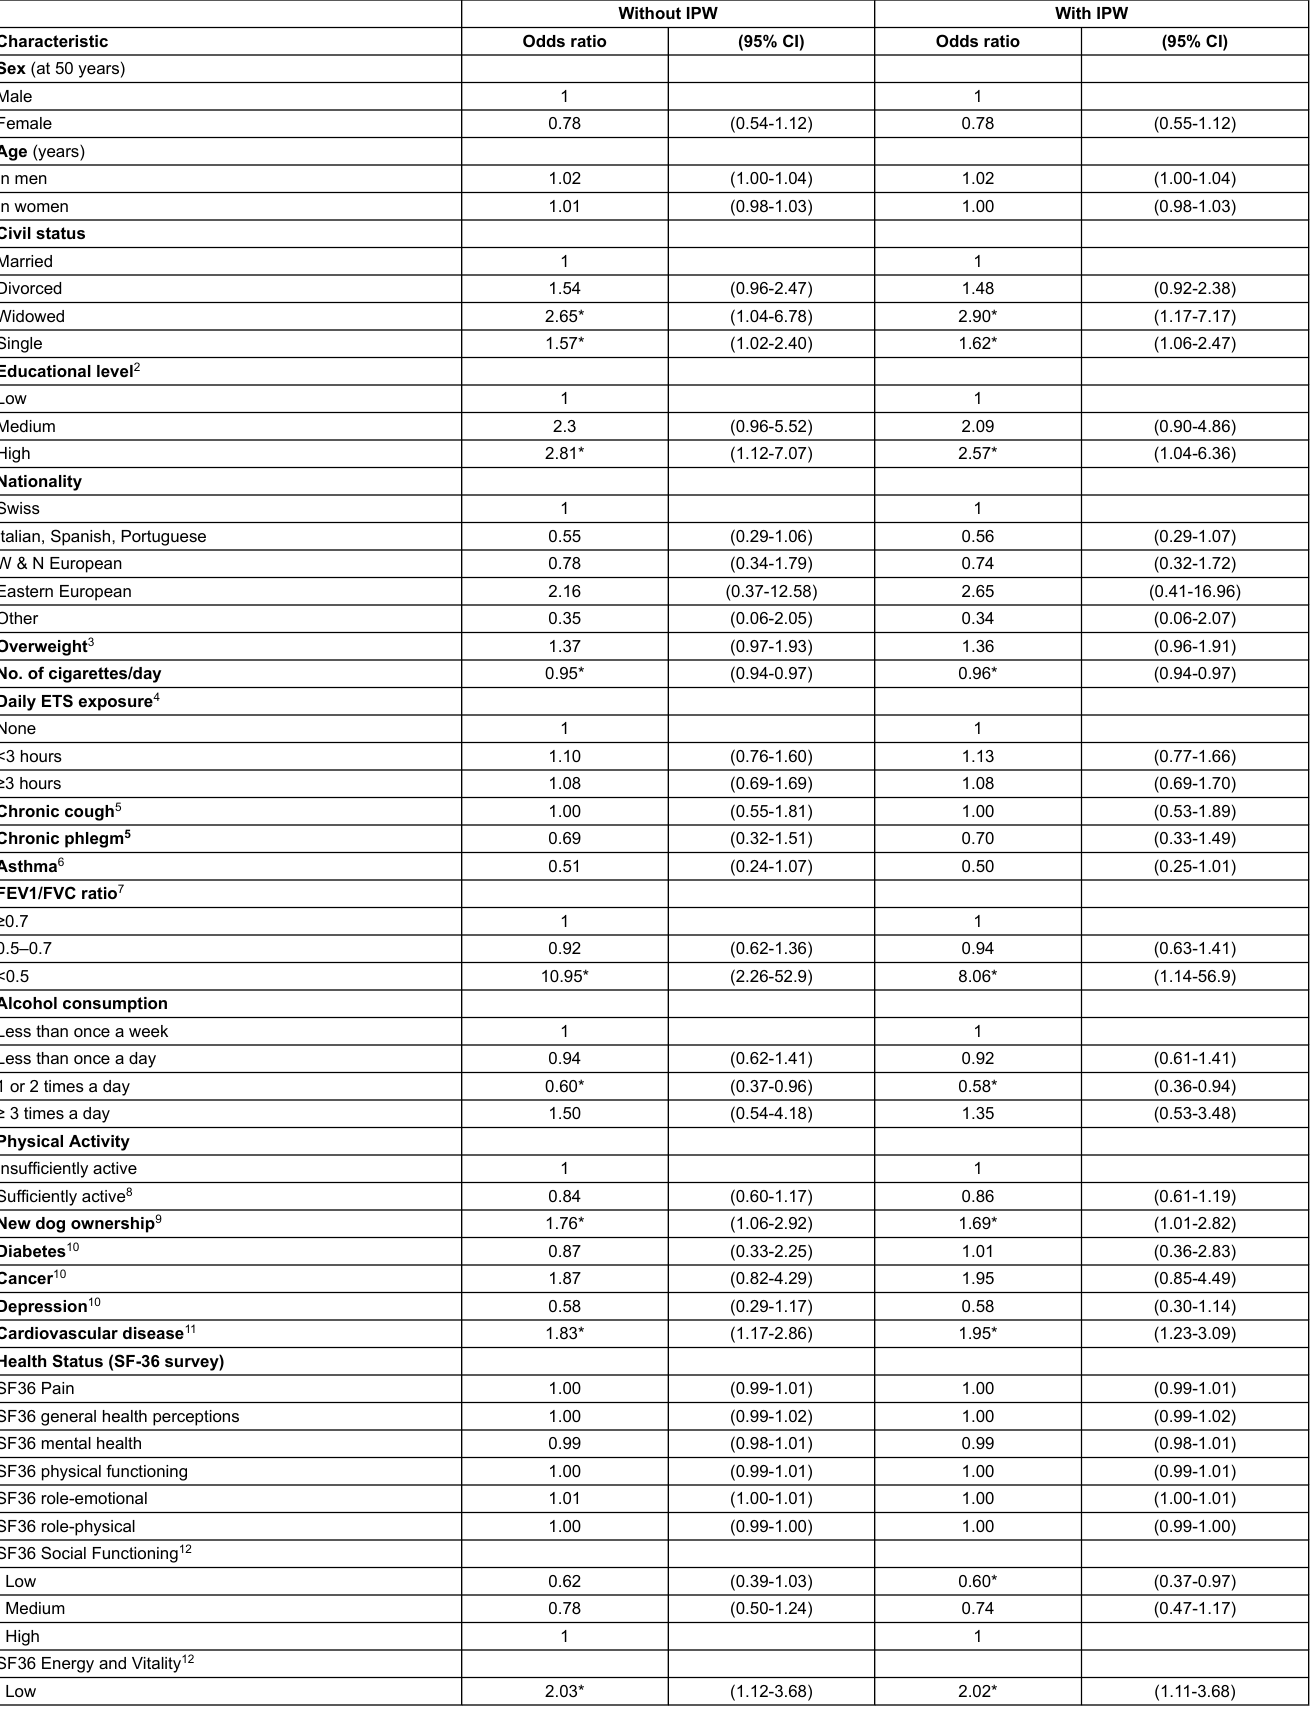
Table S5: Estimated independent associations of smoking cessation between SAPALDIA2 (2002) and SAPALDIA3 (2010/11) with different personal characteristics assessed at SAPALDIA2, without and with inverse probability weighting